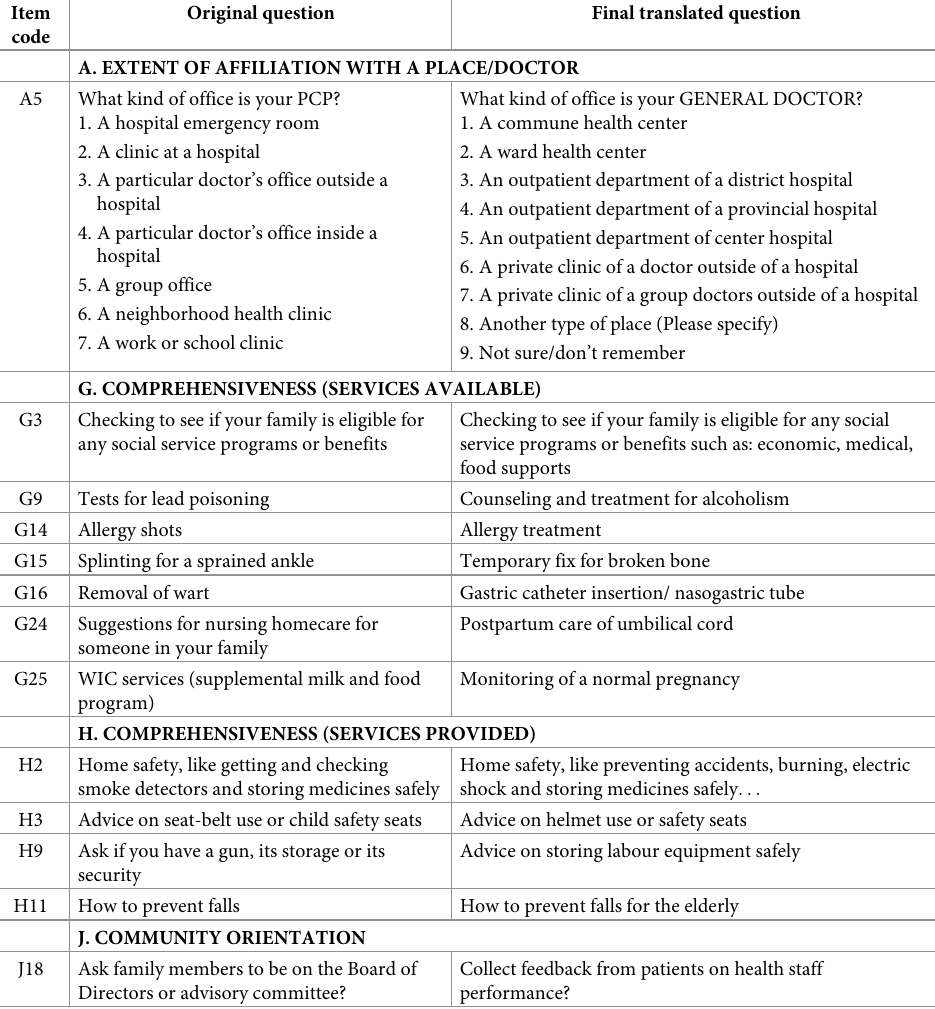
Table 1. Changes in the final translated questionnaires from the original